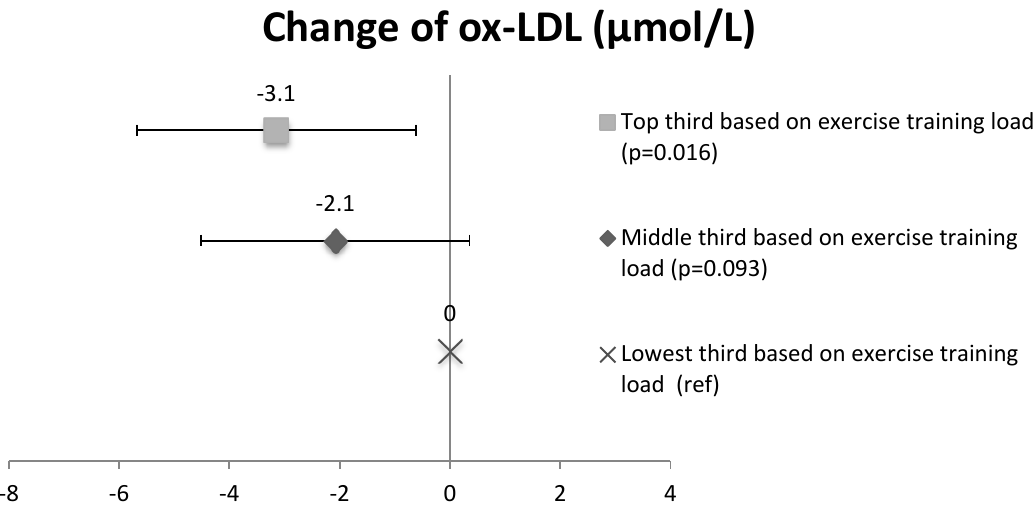
Figure 2. The change of oxidized LDL lipids in the intervention group (CAD and CAD + T2D) based on the exercise training load of the subgroups. Mean and confidence intervals, CI.